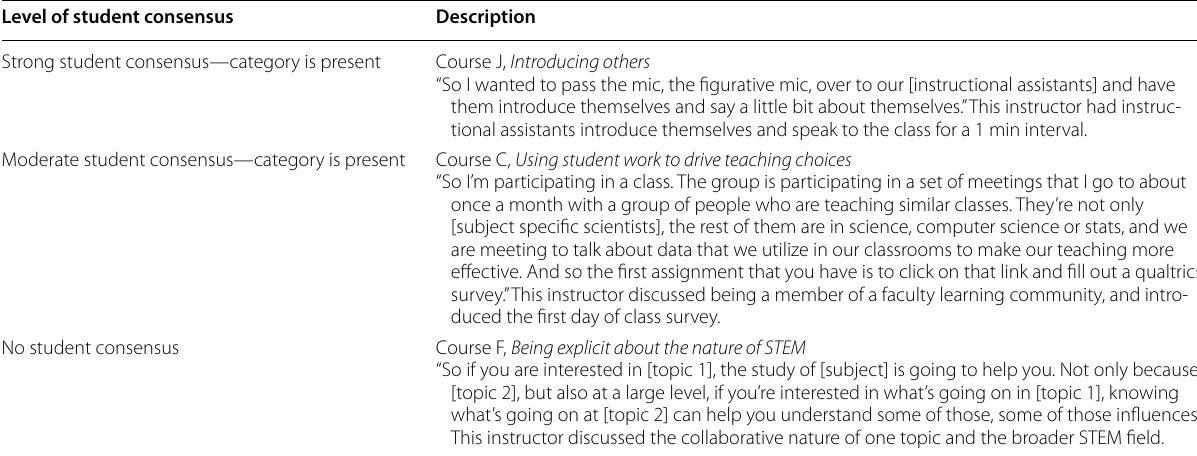
Table 2 Example non-content Instructor Talk from instructors who dedicated between 0 and 4% of 1 min intervals to messaging